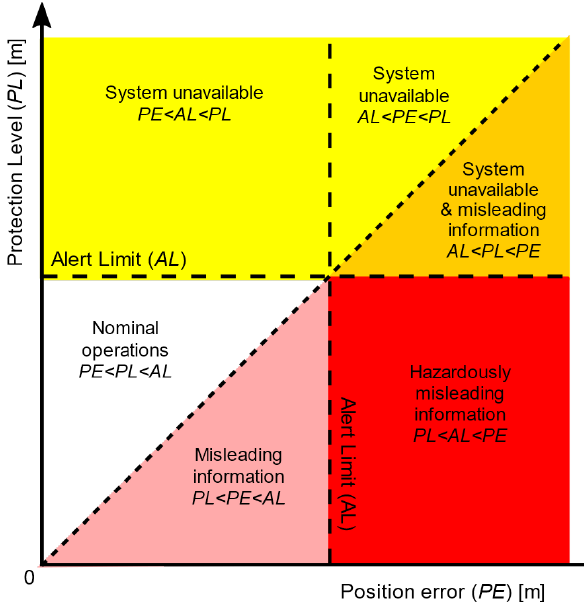
Figure 2. Interpretation of Stanford diagram based on 4 relations of system availability [4].